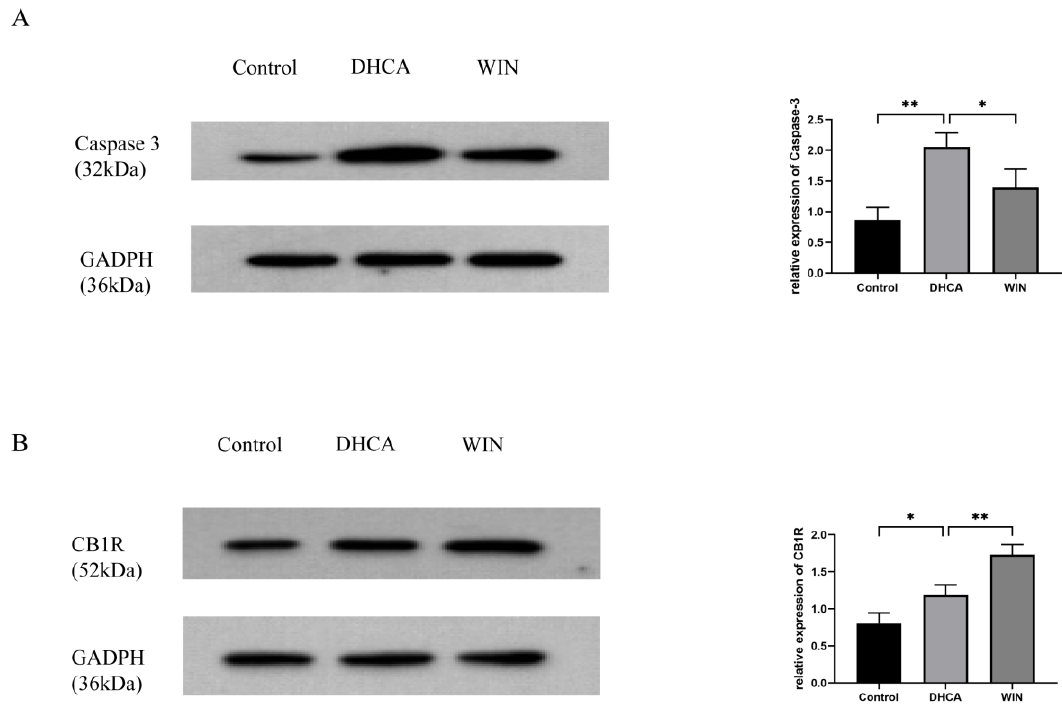
Figure 5. WIN55, 212-2 downregulates the expression of caspase 3 ( A ) and upregulates the expression of CB1R ( B ) in the hippocampal tissue of DHCA rats. n = 3. * p < 0.05, ** p < 0.01. DHCA, deep hypothermia circulatory arrest. WIN: WIN55, 212-2.